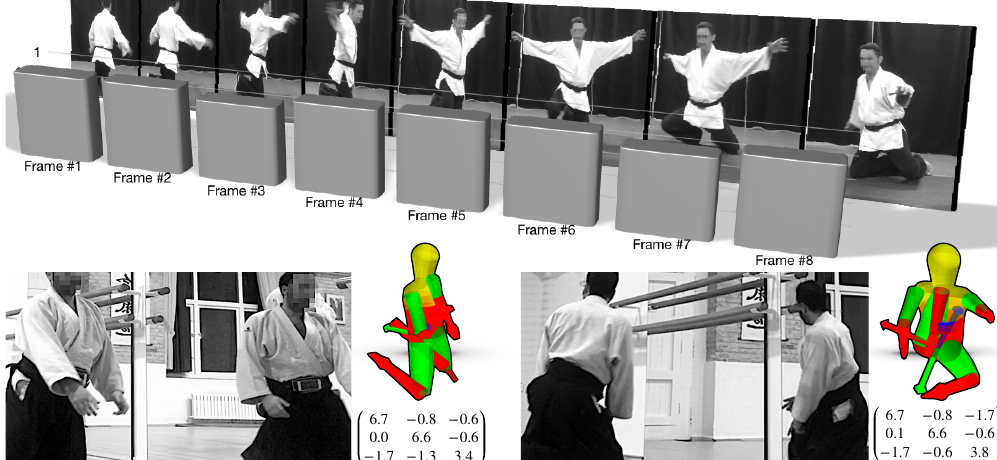
Figure 7. Top: Example of the constancy of the angular momentum (normalized L zz component, specifically) in the case of a high moment of inertia shikko u-turn (open arms). Bottom: Approximate reconstruction of the tensor of inertia with the Yeadon package. This last manual task can be facilitated if the movement is performed in front of a mirror (which allows the viewing from other angles, as in this example). Photos taken at Judelda dojo (Elda, Spain) and Sintagma dojo (Valencia, Spain),